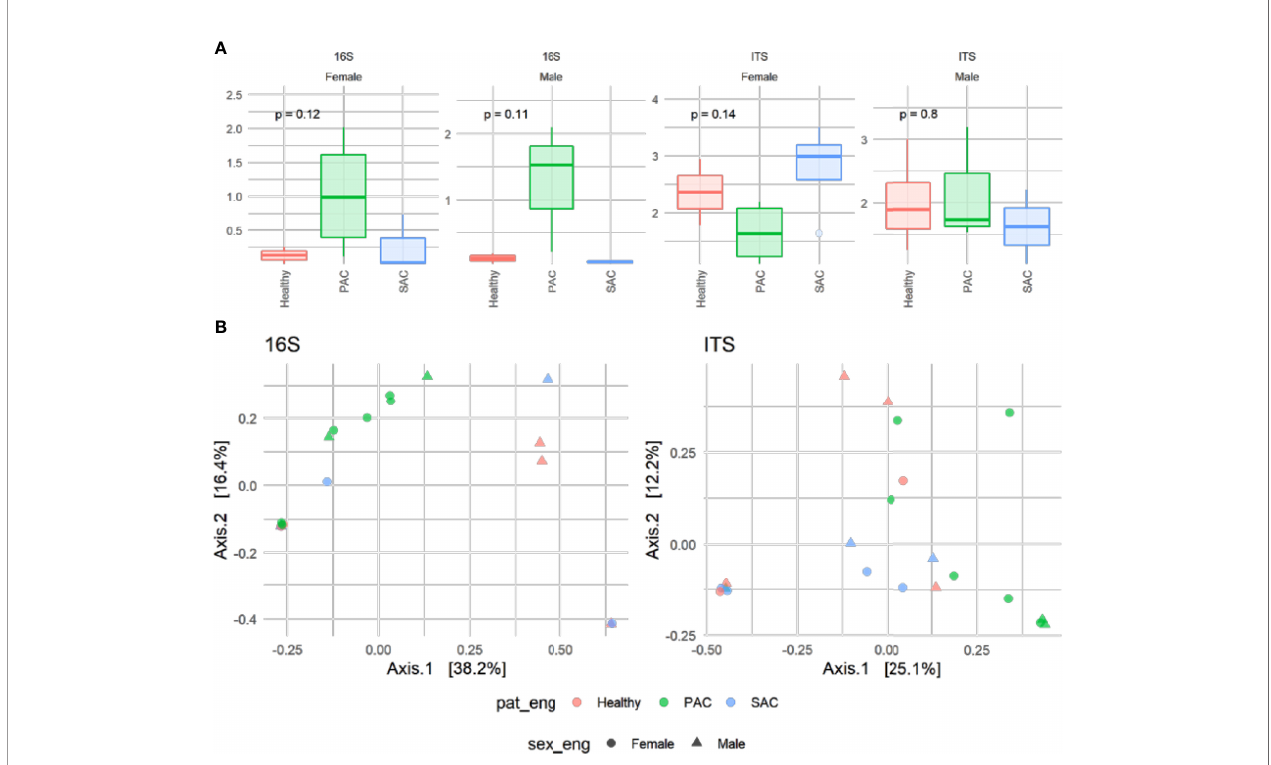
FIGURE 3 | Alpha diversity determined with Shannon index for prokaryotic (16S) and fungal communities (ITS) subdivided by sex and categorized by pathology. Resulting p-values of Kruskall-Wallis are shown on the top (A) . Principal Coordinate analysis (PCoA) of the microbiota based on Bray-Curtis distance matrix of patients annotated by sex (shape) and pathology (color) categories (B) .